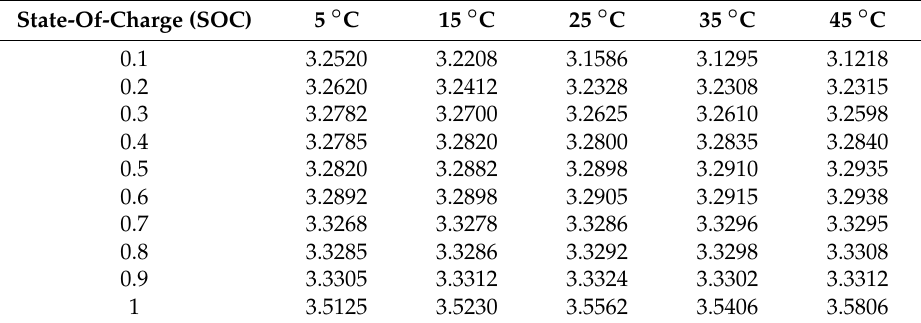
Table 3. Experimental results of Open-circuit voltage (OCV) look-up table for Cell #1 (in V). State-Of-Charge